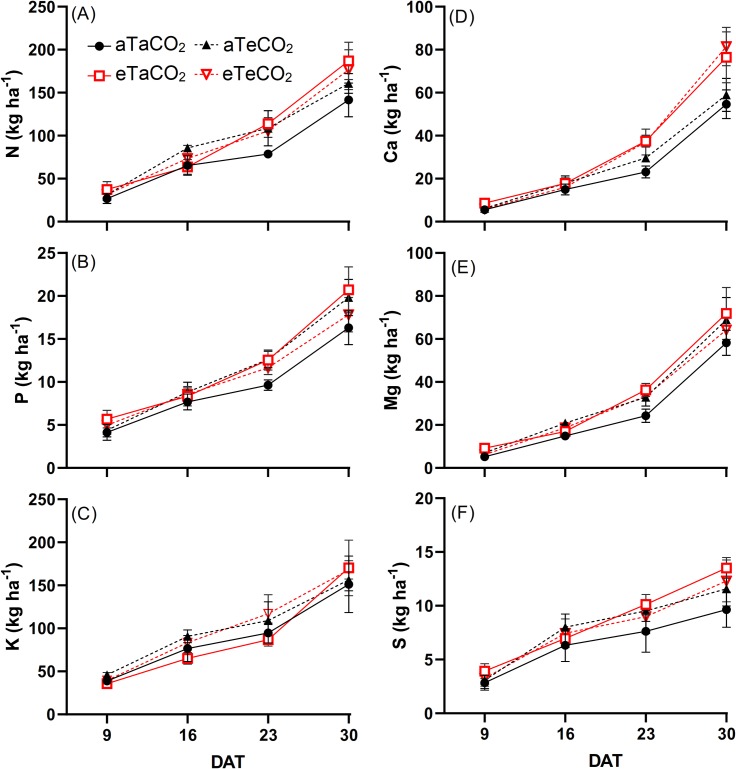
N (A), P (B), K (C), Ca (D), Mg (E) and S (F) accumulation of P. maximum shoot during the experiment at 9, 16, 23 and 30 days after treatments (DAT). Treatments: aTaCO2 (ambient temperature and ambient [CO2]), eTaCO2 (2°C above ambient temperature and ambient [CO2]), aTeCO2 (ambient temperature and 200 ppm above ambient [CO2]), and eTeCO2 (2°C above ambient temperature and 200 ppm above ambient [CO2]). Bars show means and SE of four replicates.